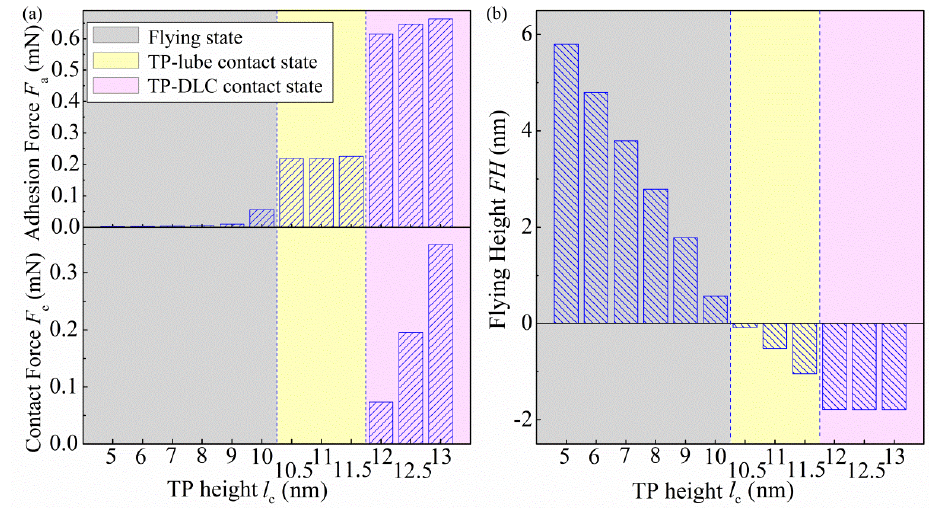
Figure 9. Force and flying height versus TP height under t lub = t DLC-disk = t DLC-slider = 2 nm, z r = 10 nm: ( a ) Adhesion force F a , Contact force F c and ( b ) Flying height FH .